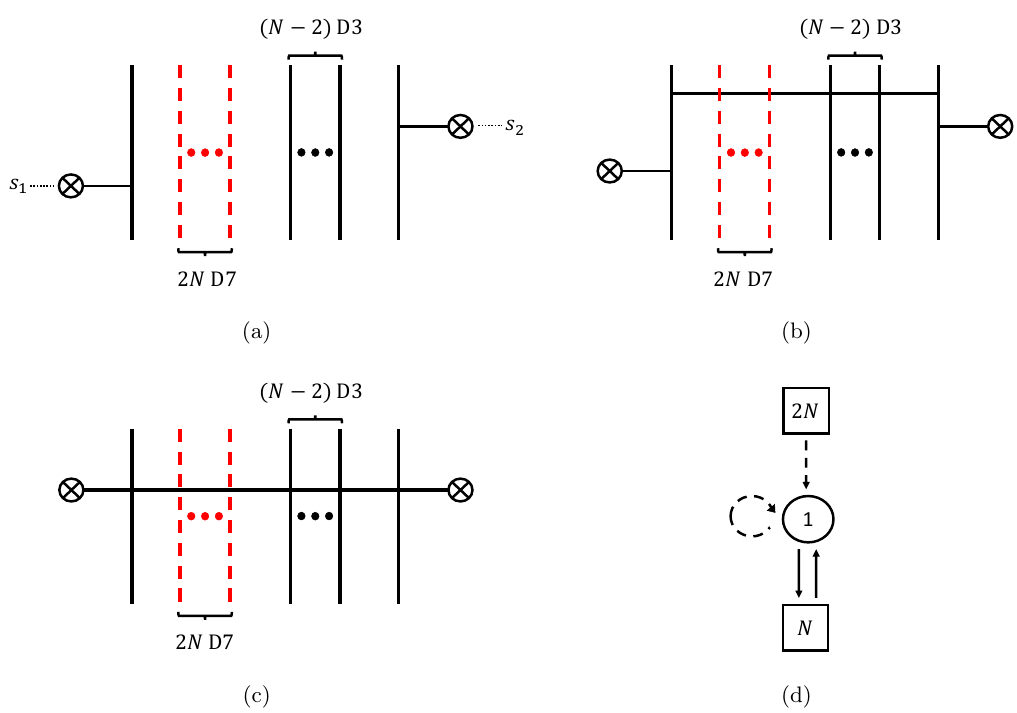
Figure 8 . (a) A brane con(cid:12)guration realizing the ’t Hooft operator with the magnetic charge B = (cid:0) e 1 + e N . (b) Introducing a smooth monopole with magnetic charge e 1 (cid:0) e N to (cid:12)gure 8(a). (c) The brane con(cid:12)guration for reading o(cid:11) the SQM describing the contribution of the monopole screening of the ’t Hooft operator in the sector v = 0 . (d) The quiver diagram for the worldvolume theory on the D1-branes in the con(cid:12)guration in (cid:12)gure